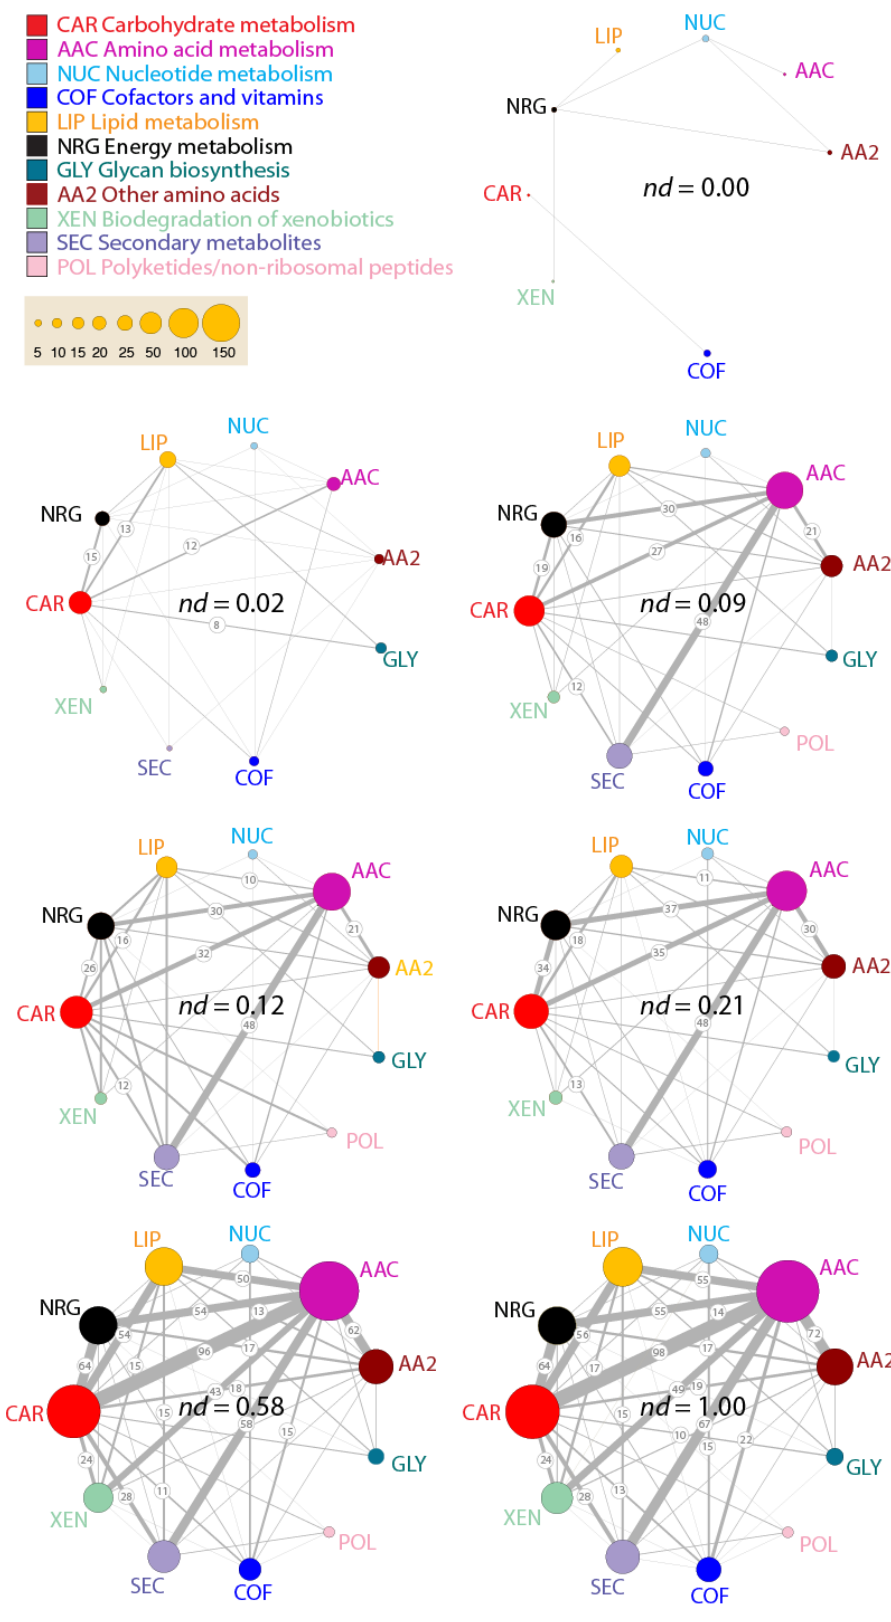
Figure 5: Graph representations describing the evolutionary build-up and sharing of enzymatic activities in metabolic evolution. The area of vertices is proportional to the number of enzymes and the width of edges is proportional to the number of shared enzymatic activities between mesonetworks. Consequently, the graphs display both the evolutionary accumulation of enzymes (see Figures 3 and 4) and the build-up of patterns of recruitments between